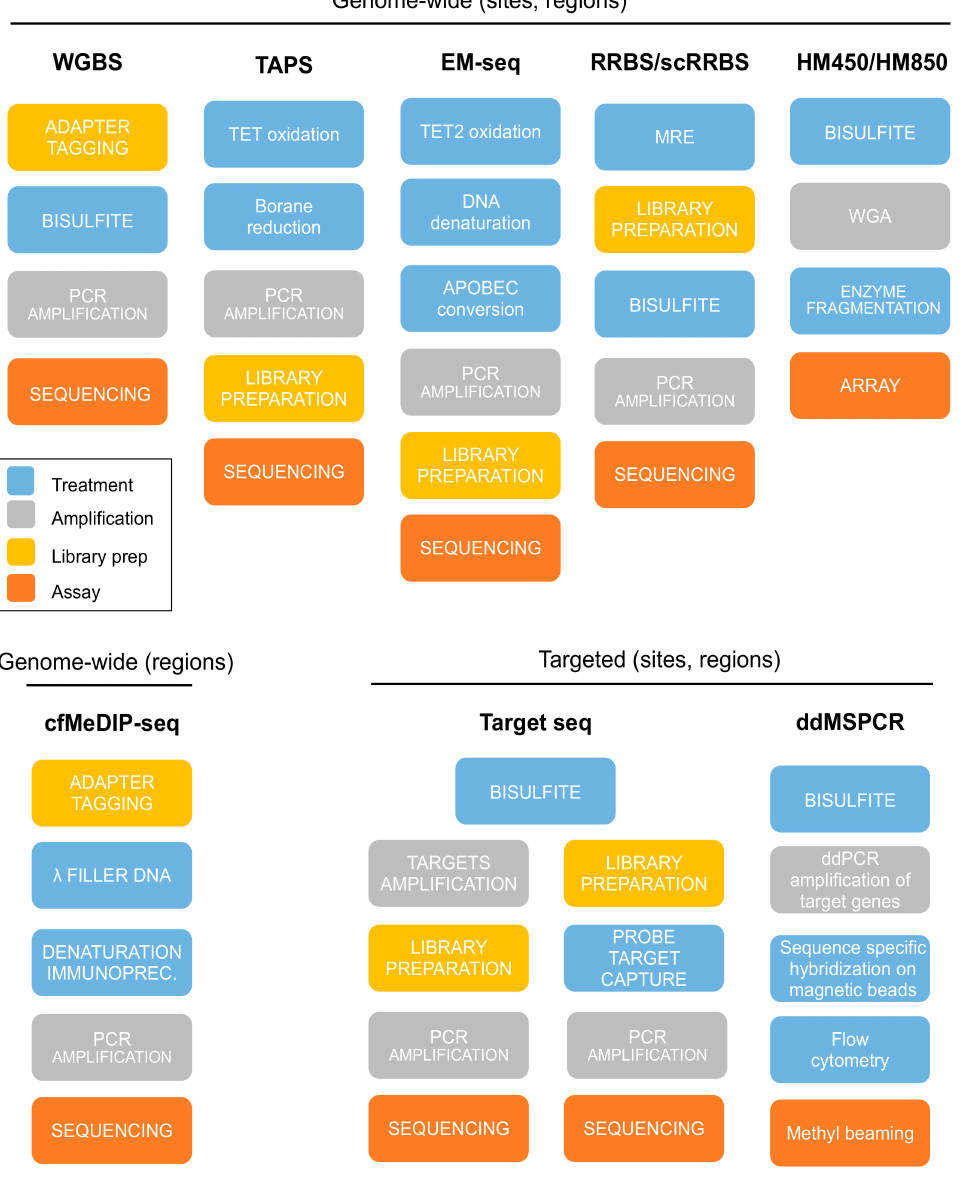
Figure 2. SummaryoftheexperimentalassaysforDNA-methylationevaluation. Genome-widetechniques include methods able to perform site and region wise analysis, such as whole genome bisulfite sequencing (WGBS), TET-assisted pyridine borane sequencing (TAPS), enzymatic methyl-sequencing (EM-seq), reducedrepresentationofbisulfitesequencing(RRBS,single-cellRRBS(scRRBS)),andinfinium methylation arrays (HM450, HM850), and methods analyzing DNAm regions only, such as circulating free methylated DNA immunoprecipitation sequencing (cfMeDIP–seq). Targeted methods include target bisulfite sequencing (target bisulfite seq) and PCR-based assays, including methylation specific PCR (MSPCR) and droplet digital methylation specific PCR (ddMSPCR). MRE: methylation restriction enzyme, WGA: whole genome